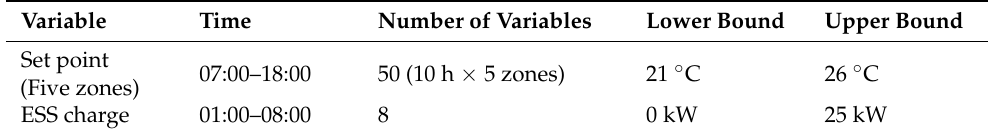
Table 7. Bounds of the GA parameters to be